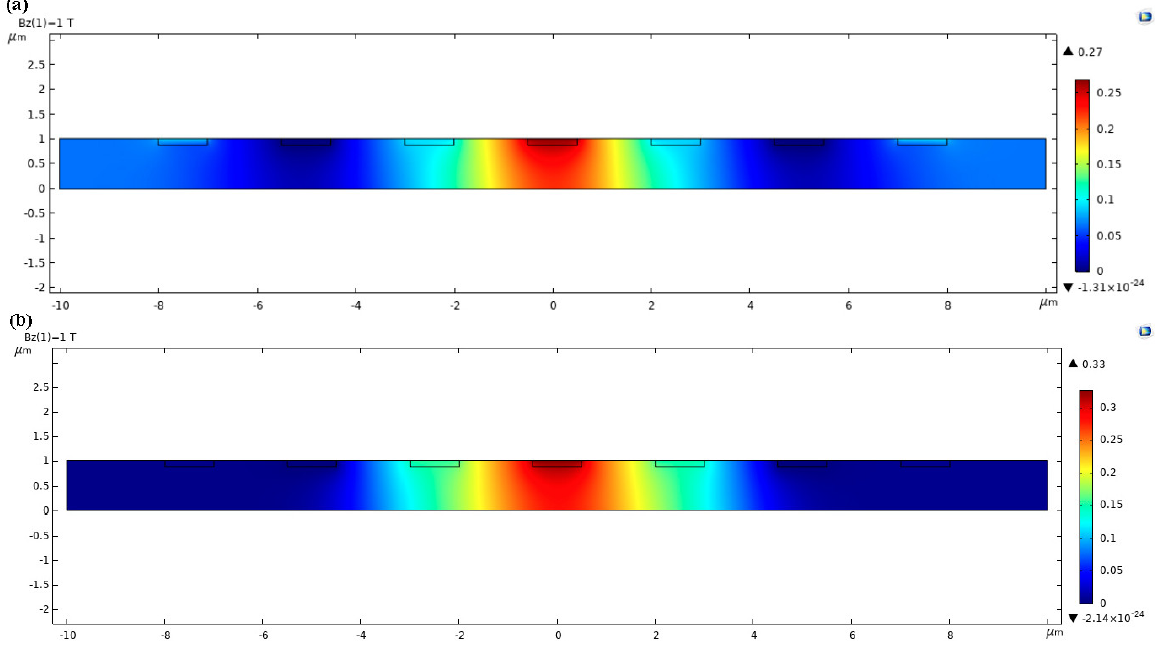
Figure 3. Models in COMSOL of 7CVHS ( a ) and 5CVHS ( b ), where the colors illustrate the voltage distributions.